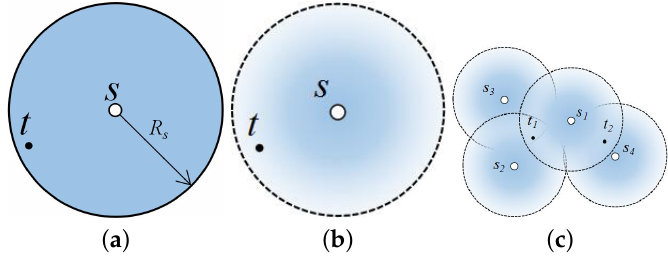
Figure 1. The difference between the idealized 0/1 disk model and the probabilistic sensing model. ( a ) Idealized 0/1 disk model; ( b ) probabilistic sensing model; ( c ) the target t 1 needs three probabilistic sensors to achieve threshold (cid:101) , while t 2 needs